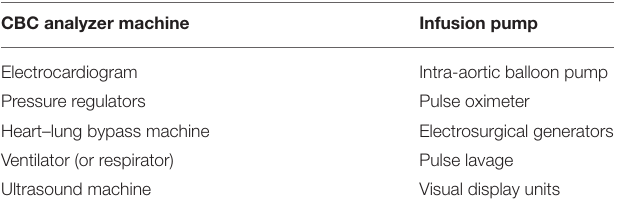
TABLE 3 | List of equipments used to evaluate pre-operative, inter-operative, and